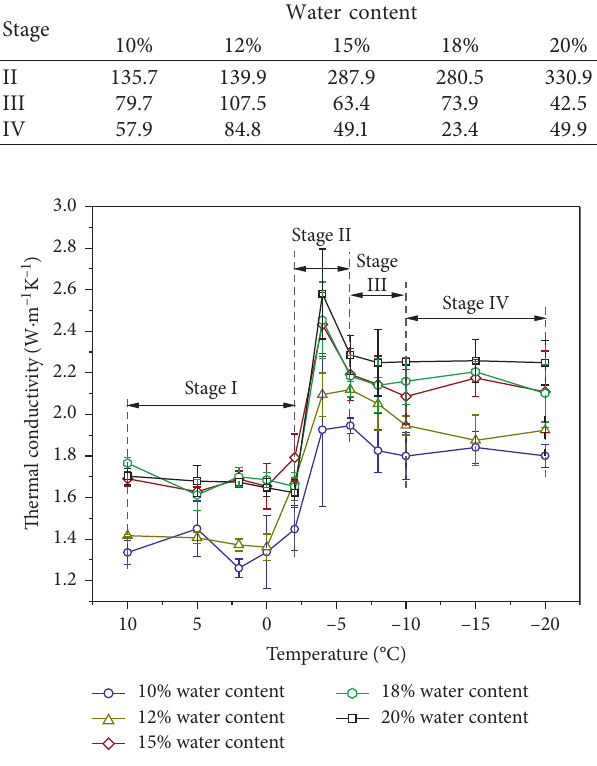
Figure 5: Variations in thermal conductivity of silty clay samples with different water contents versus temperature.